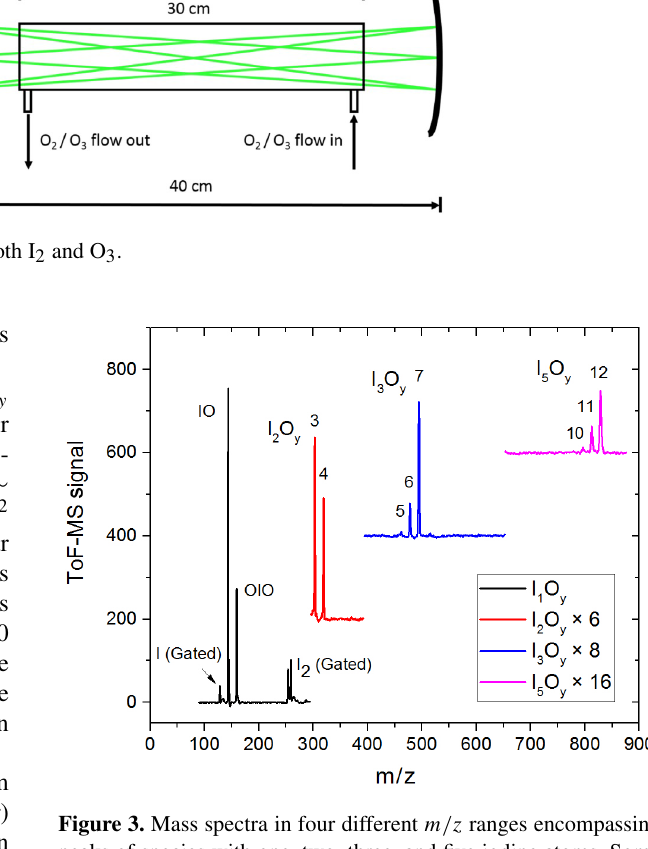
Figure 3. Mass spectra in four different m/z ranges encompassing peaks of species with one, two, three, and five iodine atoms. Some of the spectra are scaled and shifted for clarity. The mass spectra are generated by averaging the mass spectra at each time point over a 20ms experiment comprising 20 individual time